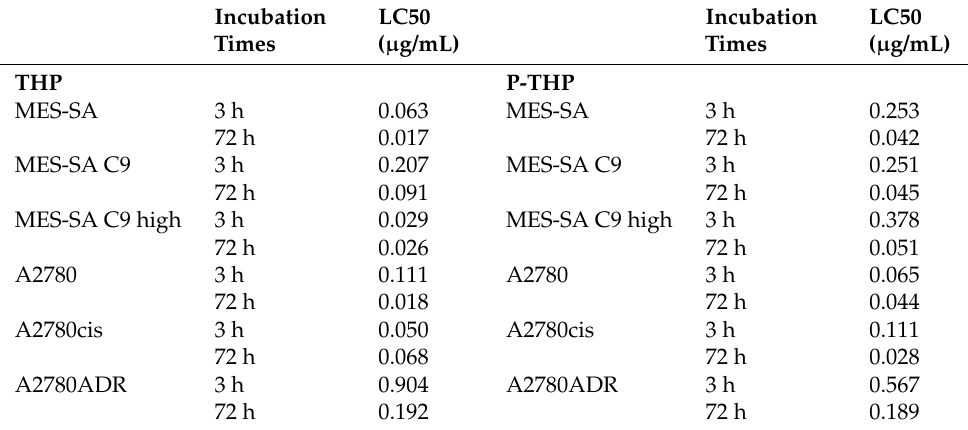
Table 1. In vitro cytotoxicity (IC 50 ) values of THP and P-THP in A2780, A2780cis, and A2780ADR after 3 h and 72 h of incubation at 37 ◦